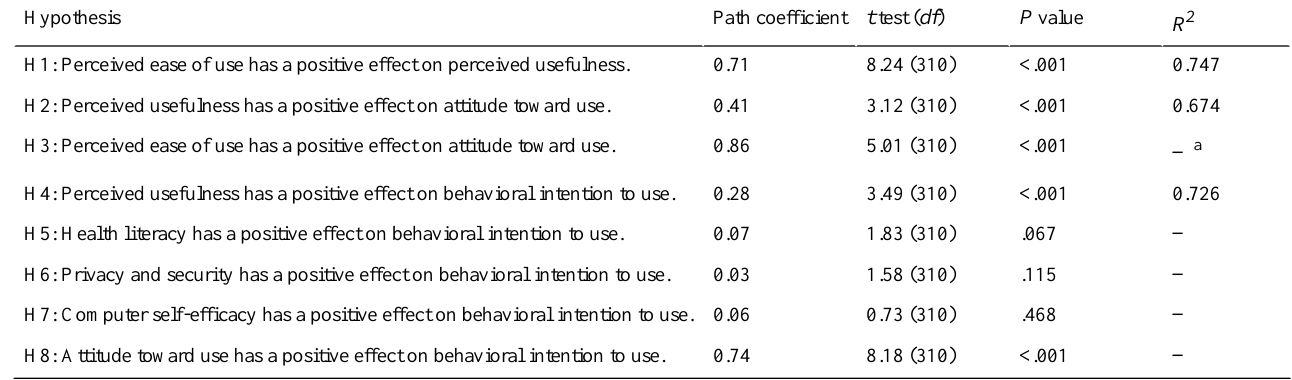
Table 6. Results of path analysis.